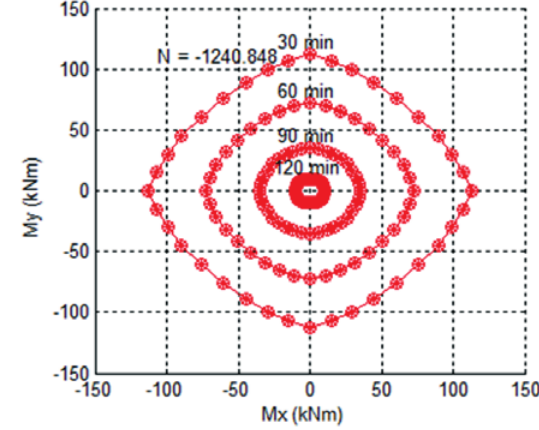
Figure 17b M - M curves of the cross-section with 4 ϕ 16 mm x y for N ⁄ = 0.40 Ncmax20